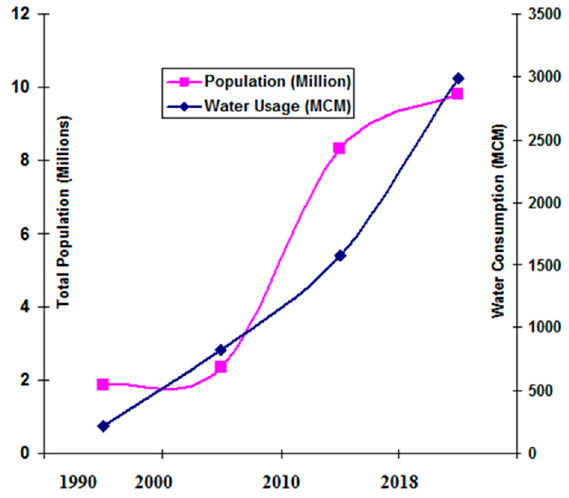
Figure 13. Relationship between annual population growth and water usage (mcm).